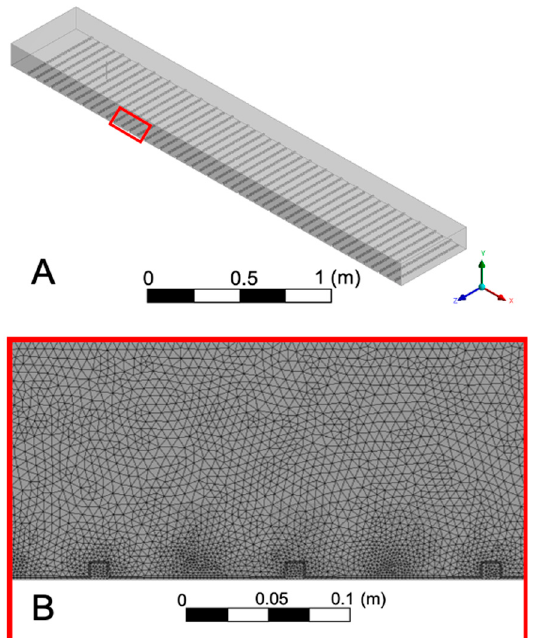
Figure 2. ( A ) Geometry of computational flume, with roughness blocks along the flume bed staggered to promote turbulent mixing. The pipe inlet, located 0.5 m downstream from the upstream edge, is used to introduce odor into an already turbulent environment. Inset of red box is shown in ( B ) that shows nodes where odor concentration and water velocities are computed. Nodes are arranged in a tetrahedral mesh with minimum spacing of 0.8 mm to capture turbulent flow over roughness blocks in the boundary layer. An adaptive mesh is used for the remainder of the geometry with a maximum distance between nodes of 5.5 mm.